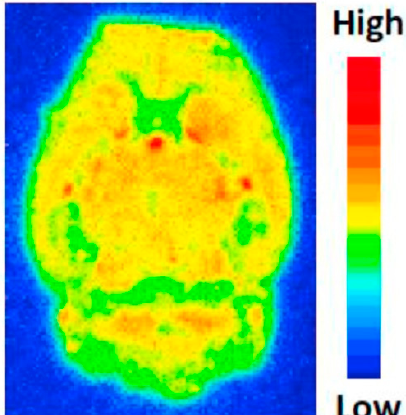
Figure 9. Ex vivo autoradiography of [ 18 F]-56 in normal rat brain. “Figure 3. Ex vivo autoradiography of [ 18 F]12b in rat brain” from the following article: Luo Z. et al. Eur. J. Med. Chem. 2018, 150, 796–808. doi: 10.1016/j.ejmech.2018.03.035. Syntheses and in vitro evaluation of new S1PR1 compounds and initial evaluation of a lead F-18 radiotracer in rodents. [224]. Copyright © Elsevier.